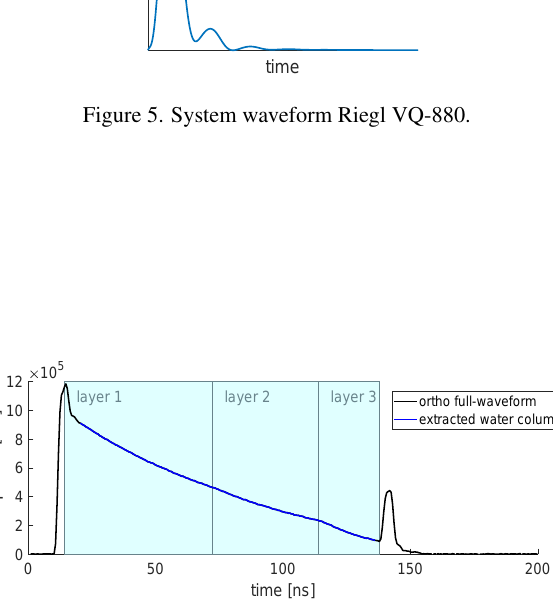
Figure 4. Differential backscatter cross section.